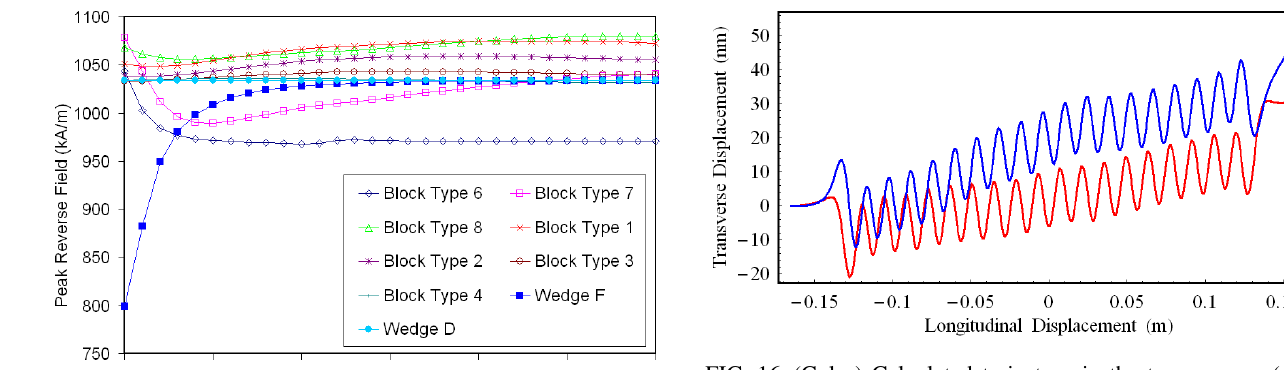
FIG. 16. (Color) Calculated trajectory in the transverse x (red) and y (blue) directions for the SC undulator.